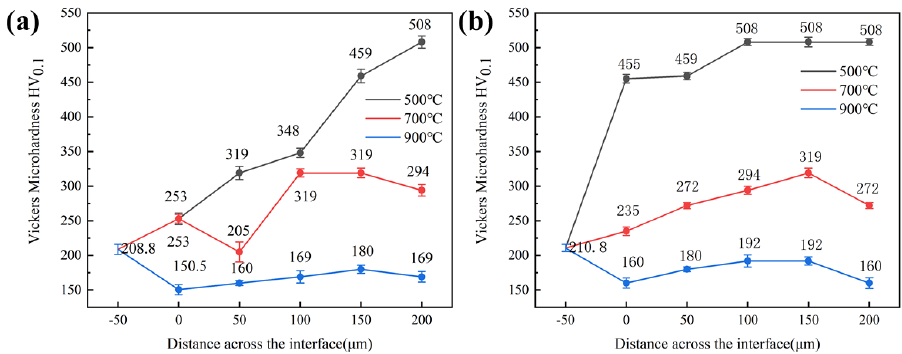
Figure 7. Microhardness–depth curves of CS and HVOF high-entropy alloy coatings heat-treated at different temperatures. ( a ) CS coating; ( b ) HVOF coating.